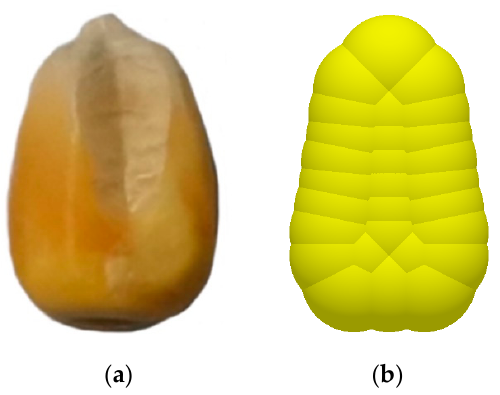
Figure 7. Corn grain model: ( a ) Actual corn seed; ( b ) Corn Seed Simulation